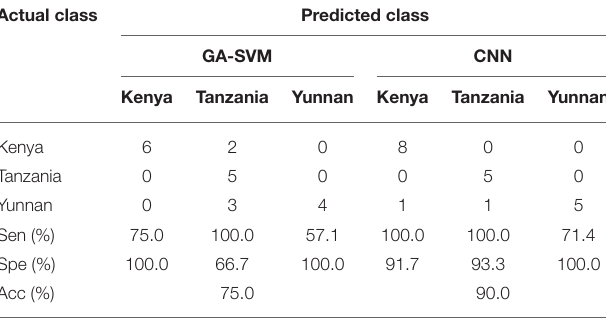
TABLE 3 | Confusion matrix detailing the multiclass discrimination results of three different geographical origins of coffee beans using genetic algorithm